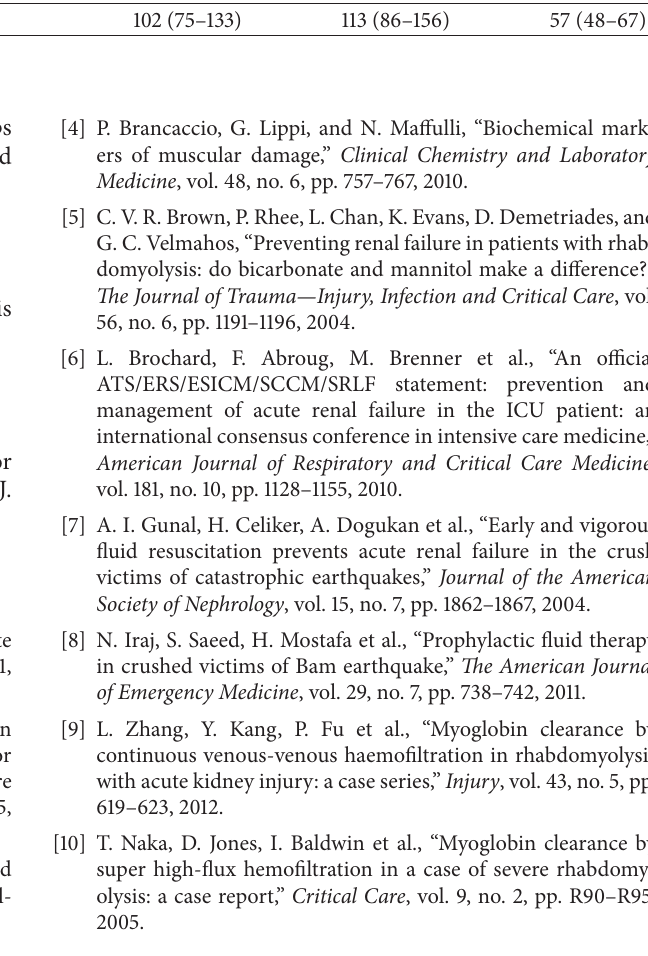
Table 4: Creatinine and blood urea nitrogen (BUN) trends in mmol/L, respectively, median (interquartile range). BUN Patient number